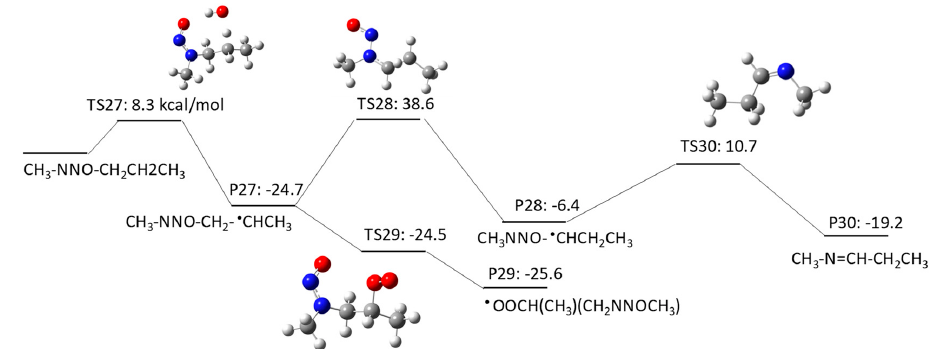
Figure 8. Free energy profile for pathway 3–2 of the HO • -induced reaction pathways for NMBA via H abstraction from a C–H bond of the -CH 2 functional group adjacent to the –CH 2 – functional groups on both sides. The numbers (kcal/mol) are the free energy of activation for the TS and free energy of reaction for the P relative to the corresponding reactant.